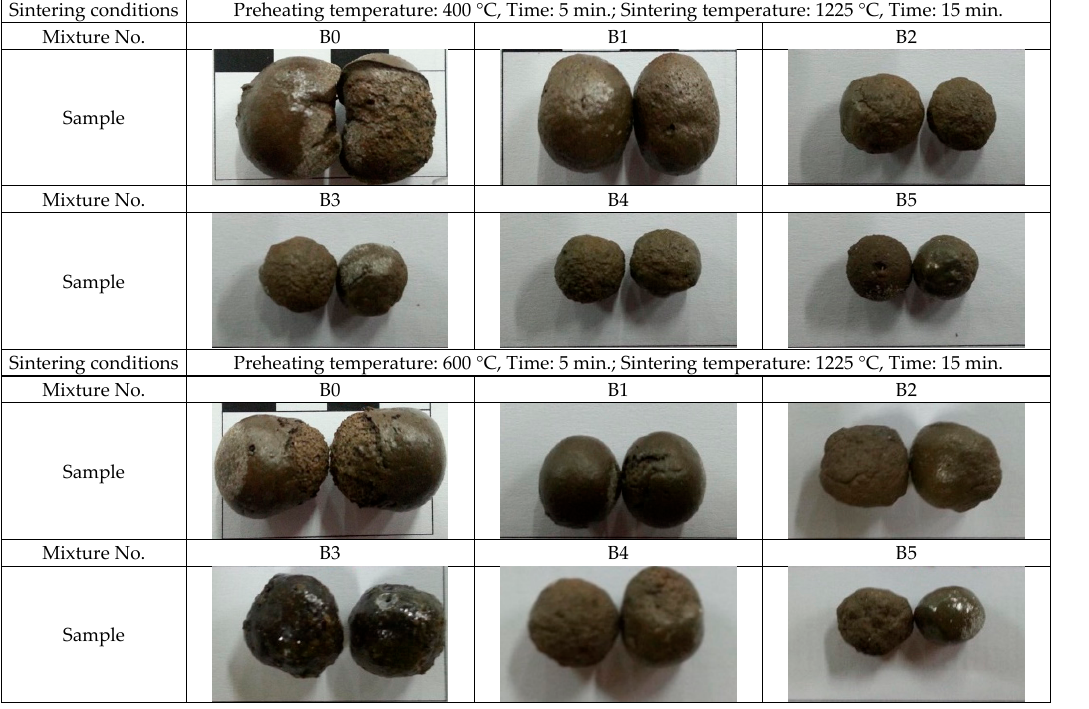
Figure 7. Appearance of paper sludge lightweight aggregate products (B series).